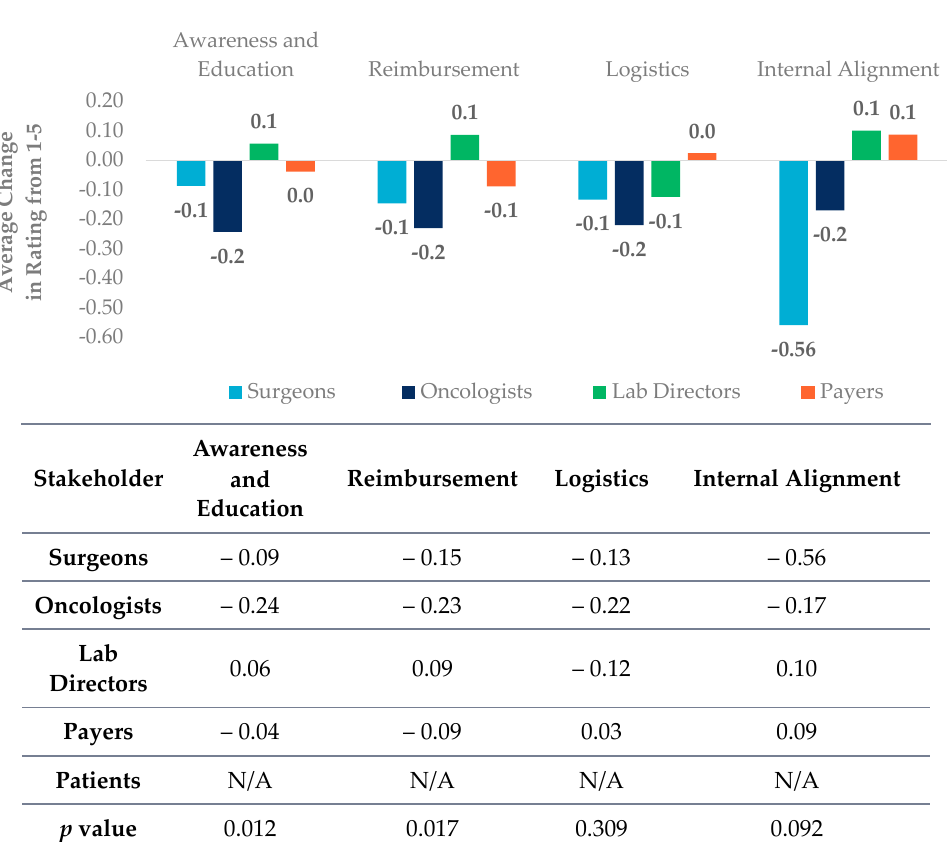
Figure 7. Lab directors, oncologists, surgeons, payers, and patients ( n = 653) were asked the following question with different responses. Please rate how challenging the following factors are to biomarker testing for oncology targeted therapies today and in 5 years on a scale of 1 to 5, where 1 is not challenging and 5 is very challenging. The differences in lab directors, oncologists, surgeons, payers, and patients ( n = 653) in responses to current barriers (Figure 1) and future barriers were assessed. The average responses between respondents were found to be statistically significantly with a p value < 0.05 for the constructs of awareness and education ( p value = 0.012) and reimbursement ( p value = 0.017) but not statistically significantly different for the constructs of logistics ( p value = 0.309) and internal alignment ( p value = 0.092). Statistical analysis was done using a one-way ANOVA. Construct definitions can be found in methods.